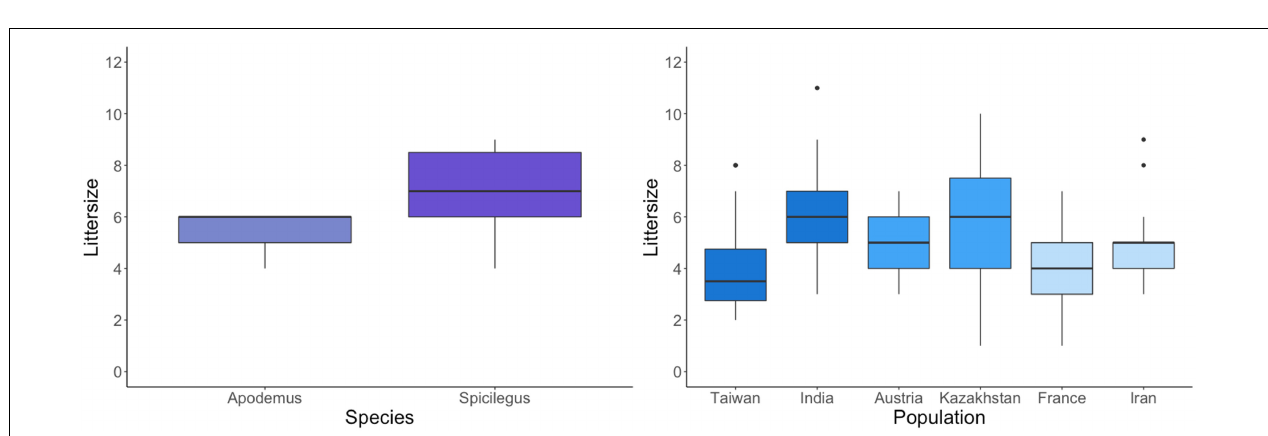
FIGURE 2 | Duration of interaction with the novel object. Species are depicted in different colors with non-commensal species in shades of violet and commensal house mouse subspecies are shown in blue. The two populations per subspecies are shown in the same color.